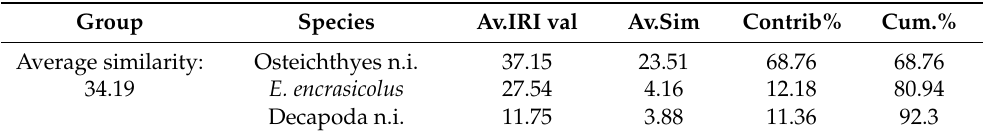
Table 6. Results of the SIMPER analysis conducted between European hake trophic groups from 2019. The average similarity between cluster groups is reported. The percentage and cumulative contribution of typifying species within-group similarity of the identified hake trophic groups is shown. The table shows results obtained for the trophic cluster B, which includes Classes II–IV. Trophic cluster A and C = less than 2 size